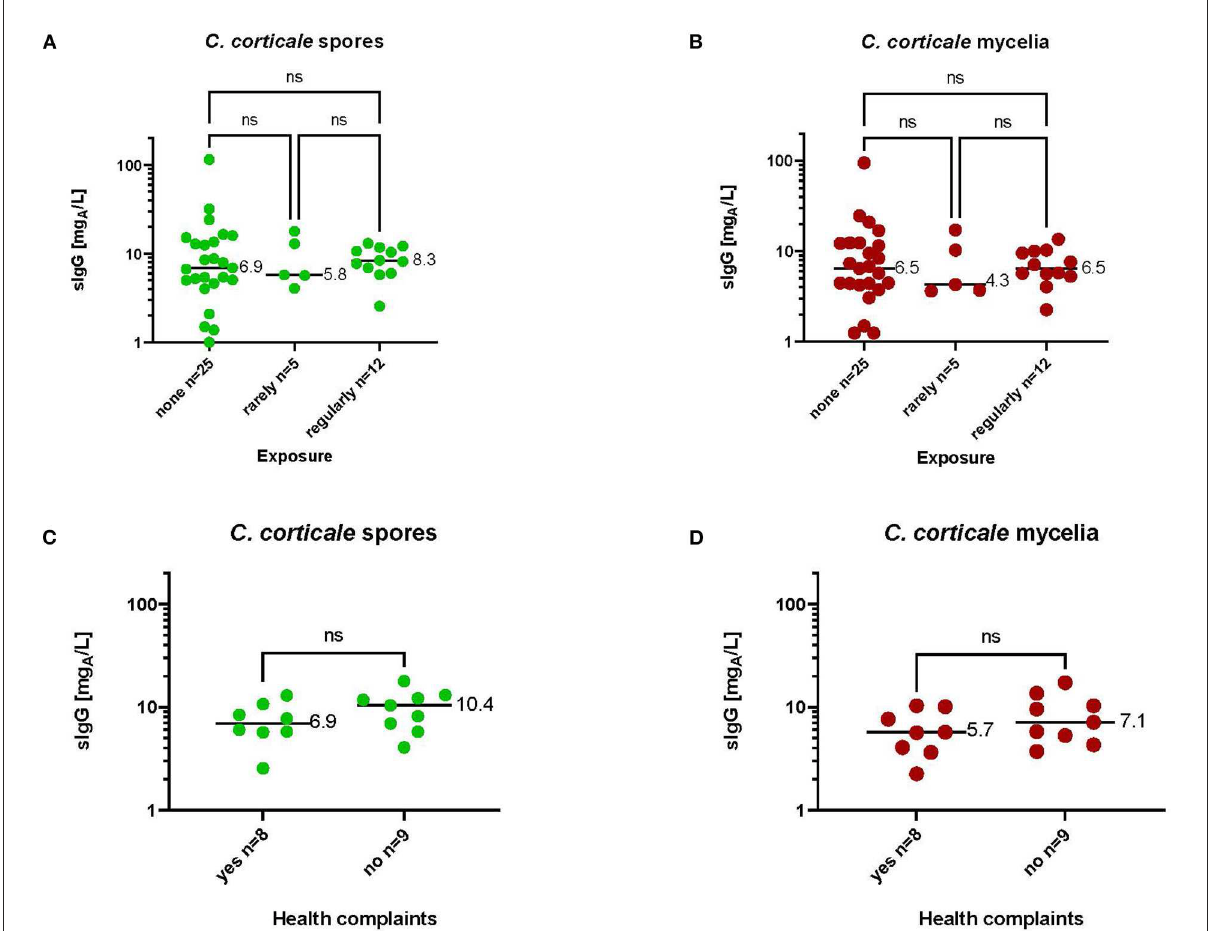
FIGURE5 Serological sIgG-concentrations to spore (A,C) and mycelia (B,D) antigens in subjects with different exposure intensities (A,B) or with or without health complaints after occupational exposure (C,D) . Medium values of sIgG-concentrations are shown in the diagrams. Significance was calculated by Kruskal-Wallis test (A,B) or Mann Whitney test (C,D)